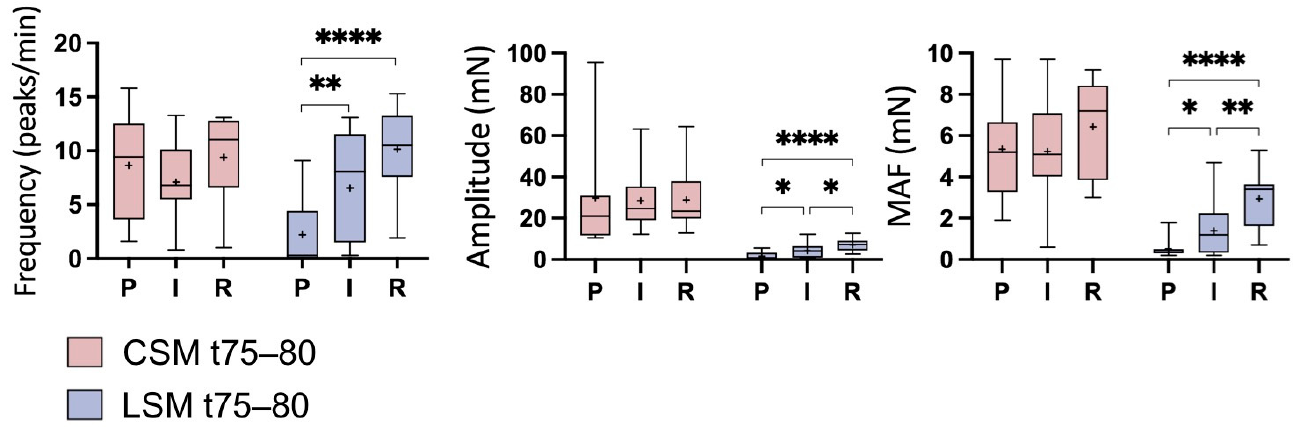
Figure 2. Box plot diagram of the basal contractile activity of jejunal circular smooth muscle (CSM) and longitudinal smooth muscle (LSM) of 12 horses during pre-ischaemia (P), ischaemia (I), and reperfusion (R) at t75–80 in the organ bath. Significant differences between the ischaemia phases (repeated measures ANOVA) are marked with an asterisk (* p < 0.05; ** p < 0.01; **** p < 0.0001). The horizontal bar displays the median and the plus is the mean, the interquartile range is represented by the box and the minimum and maximum by the whisker plots. MAF is the mean active force.